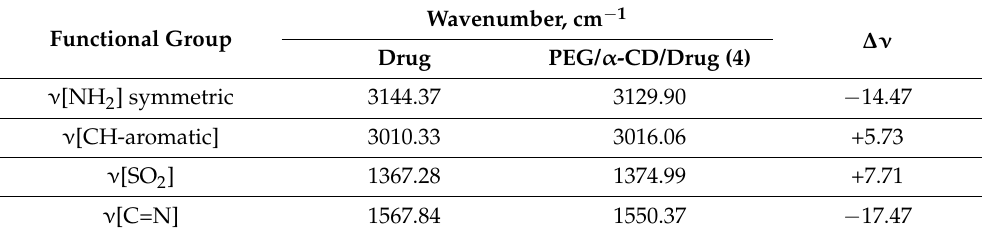
Table 2. FT-IR difference between pure drug before and after loading upon PEG/ α